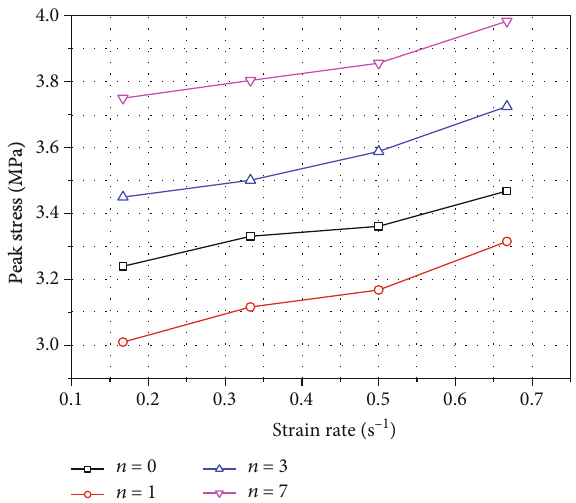
Figure 5: Strain-rate-dependent curve of peak strength at di ff erent bend numbers.